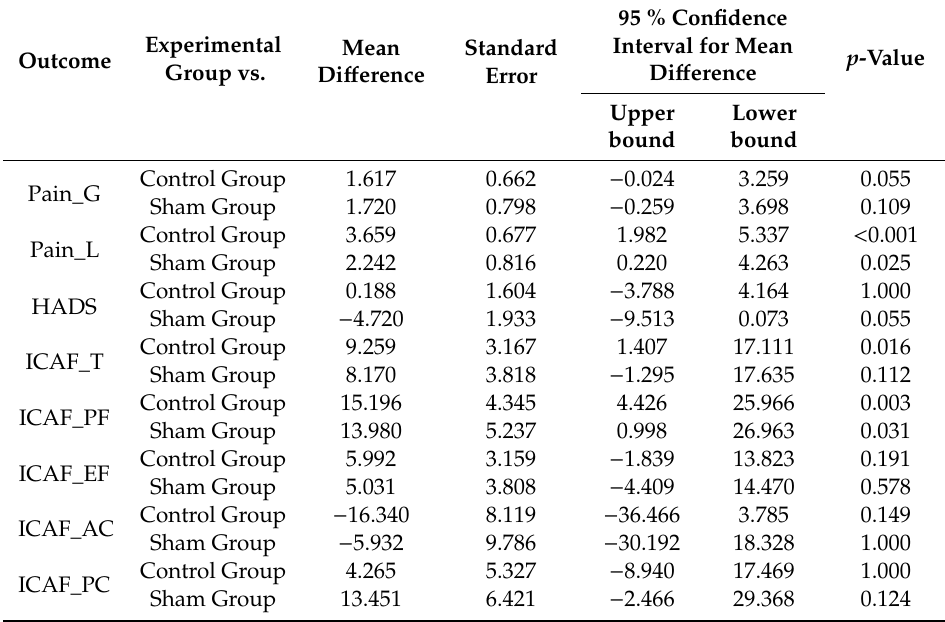
Table 4. Between-group di ff erences of the outcome